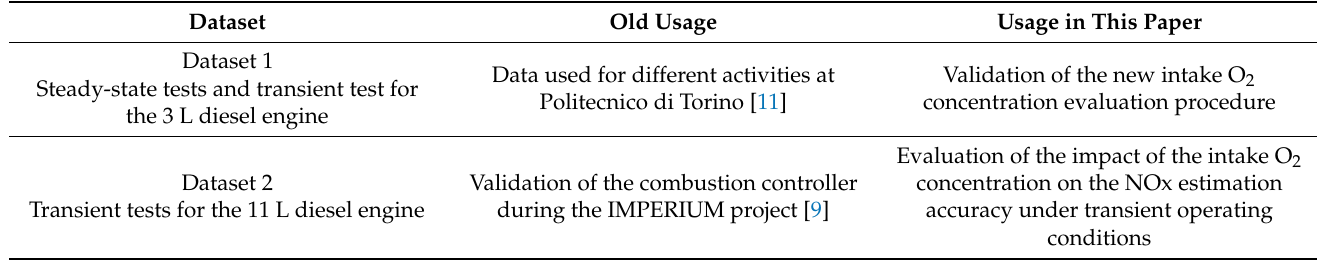
Table 3. Usage of the experimental datasets in the previous activities and for the present